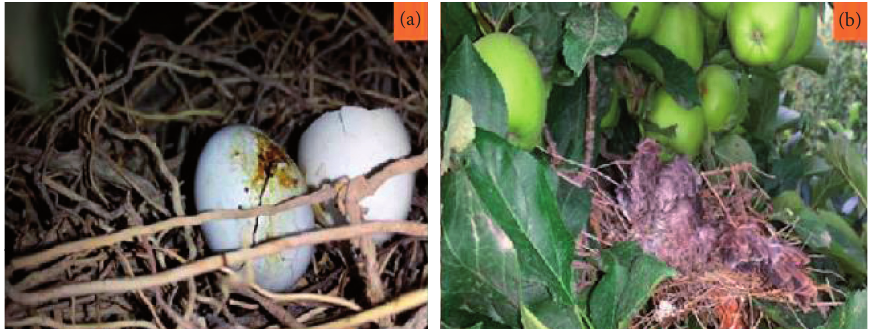
Figure 4: Predation of eggs (a) and chicks (b) of turtle doves in apple orchards during breeding seasons between 2015 and